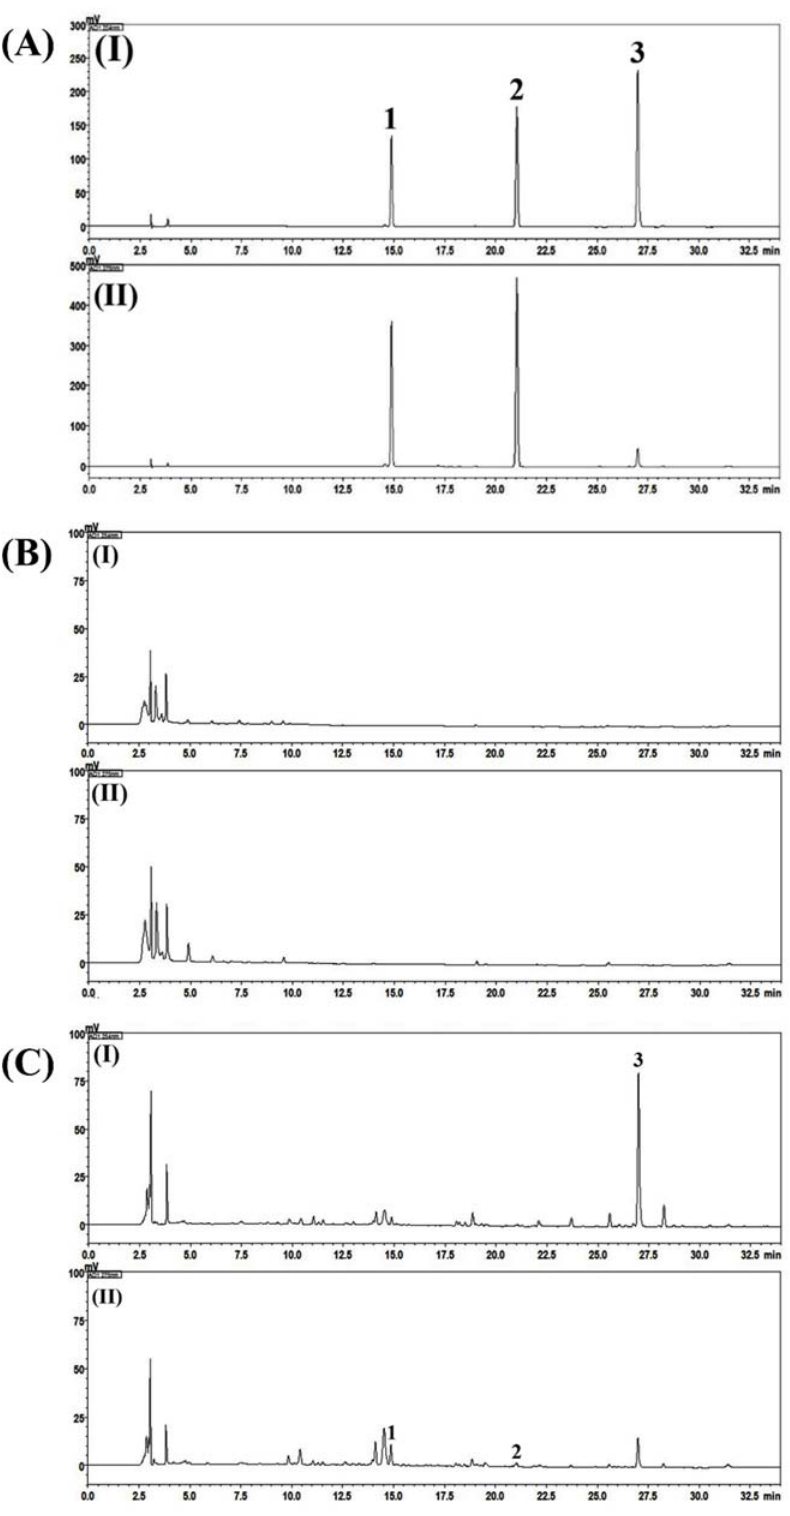
Figure 1. Representative HPLC-PDA chromatograms of the reference compounds ( A ), placebo ( B ) and Samryeongbaekchulsan sample ( C ) at 254 nm ( I ) and 275 nm ( II ). 1. Liquiritin, 2. liquiritigenin, 3. glycyrrhizin.